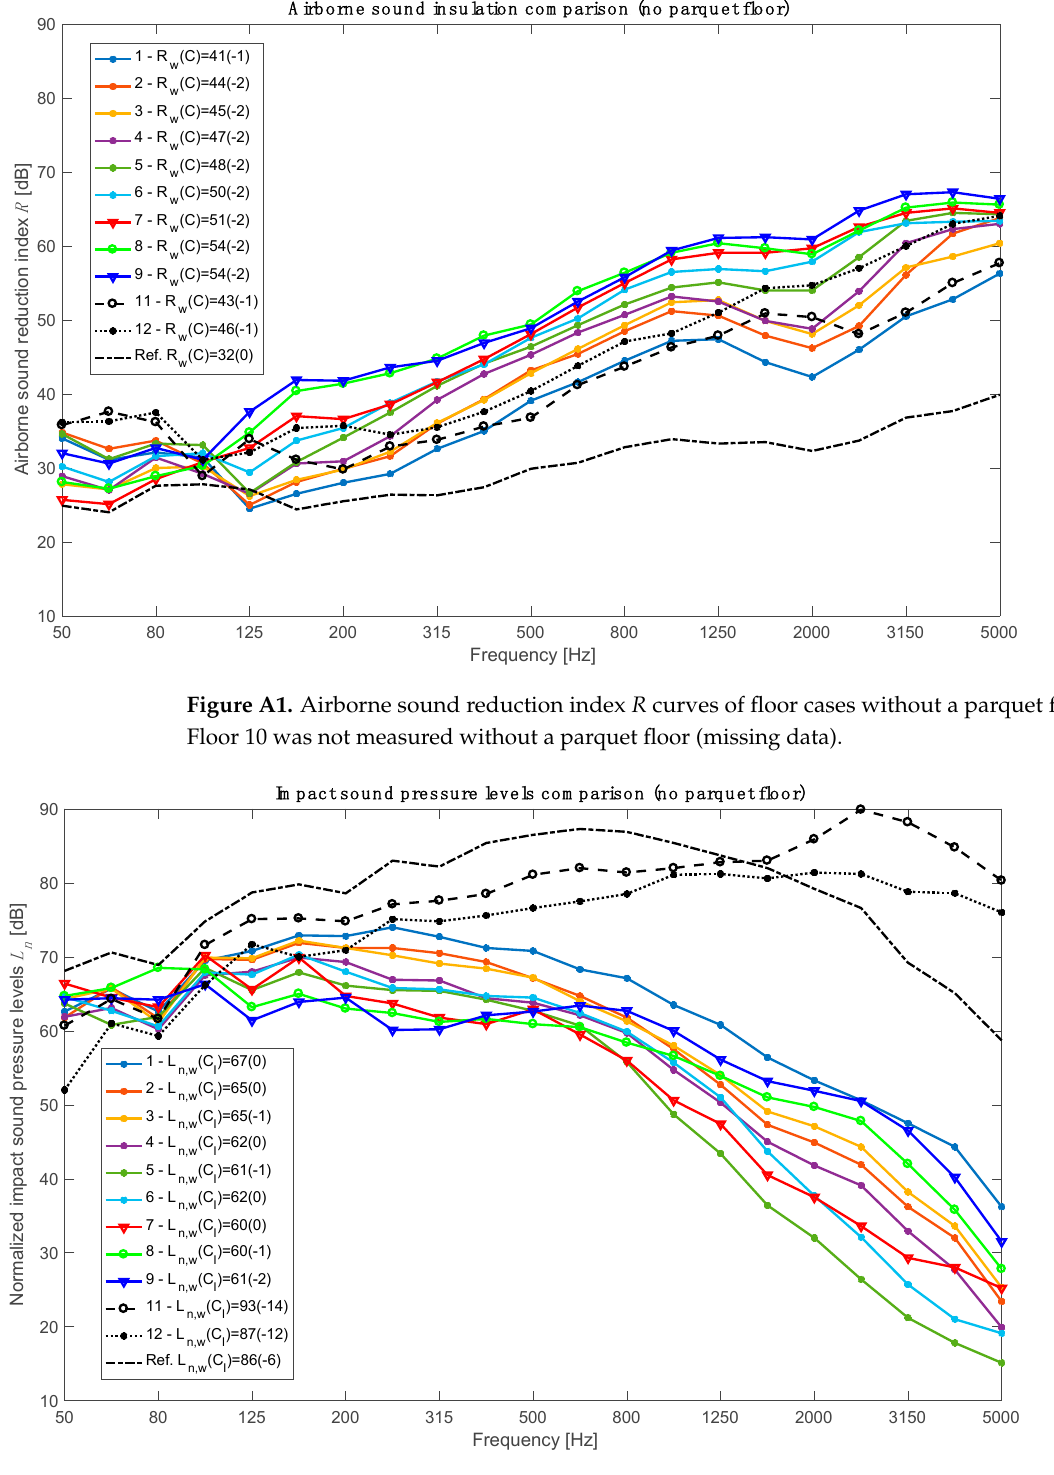
Figure A3. Photo of the laboratory measurement setup, with a sample area of 12.3 m 2 . Floor gypsum boards are used as the top layer in this case, as well as four metal components for some additional weight to approximate furniture mass at the corners.